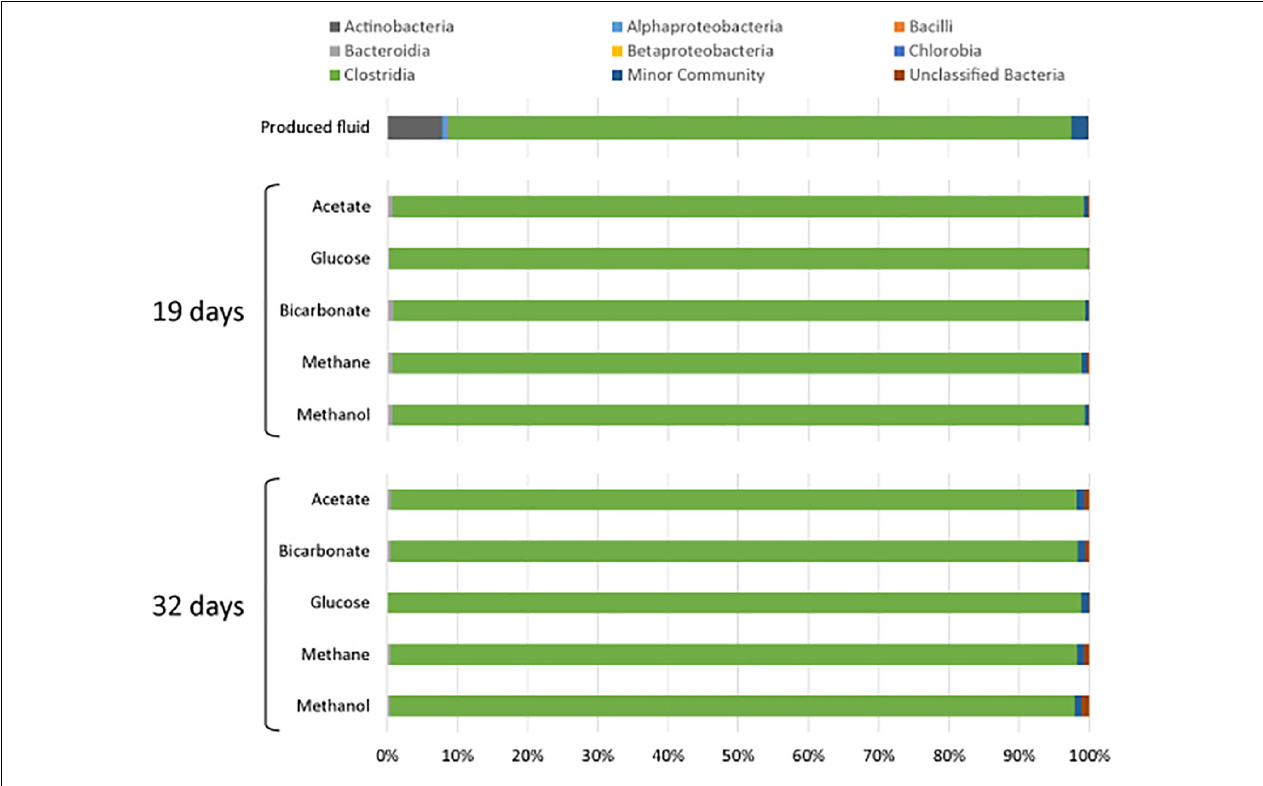
FIGURE 4 | Microbial community composition of produced water after 19 and 32 days of incubation with different carbon substrates added.